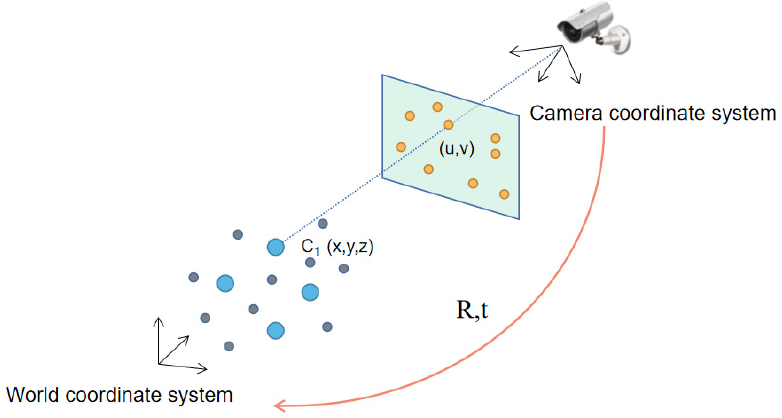
Figure 6. Relationship between 3D points (world coordinates) and 2D points (image coordinates).